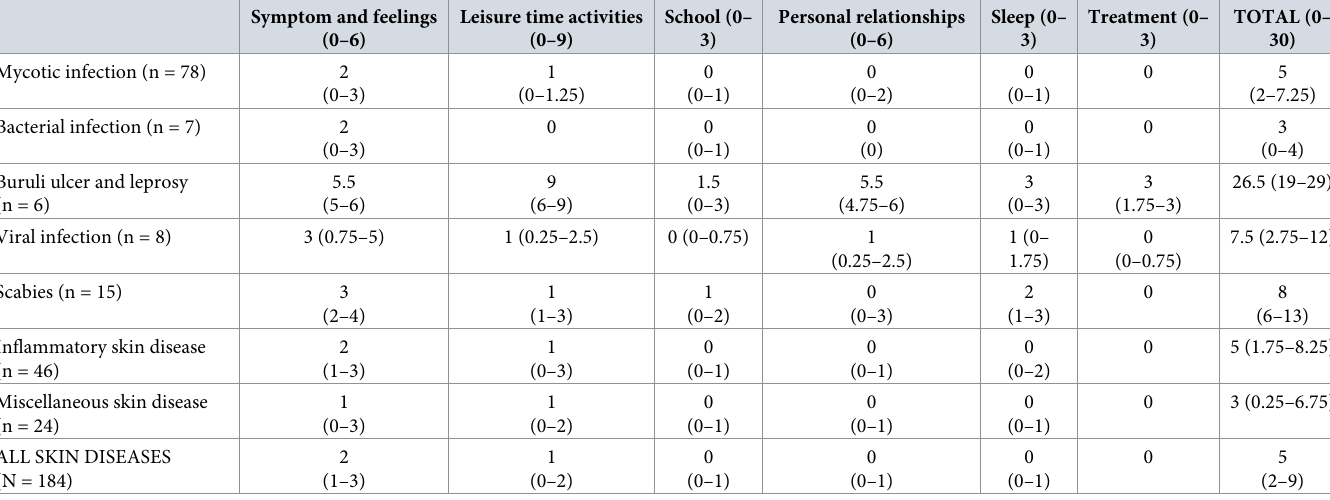
Table 3. Median and interquartile range for children’s dermatology life quality index (CDLQI) by the six